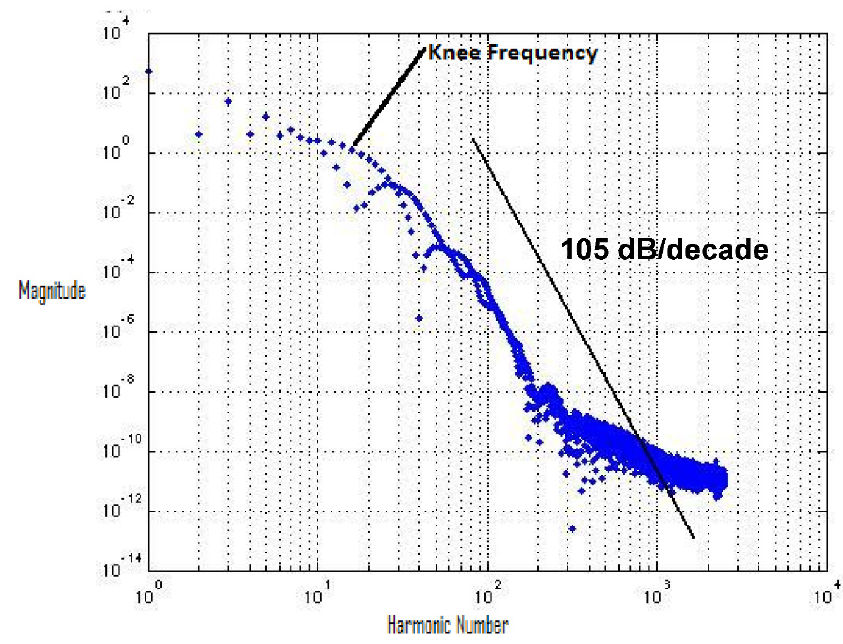
Figure 11. Spectrum roll-off of HLFF using the 130 nm process.